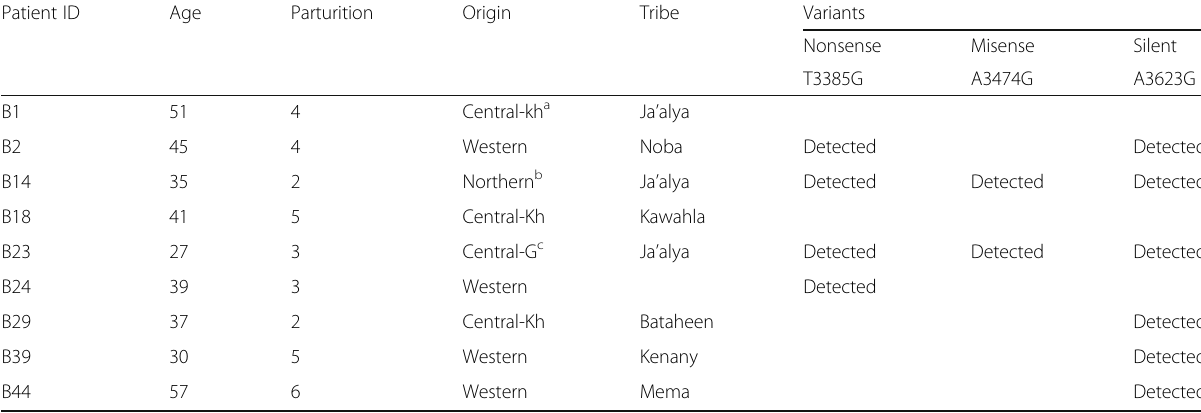
Table 4 Detected patients among the refined group to carry the following variants within BRCA2 exon 11 primer B region